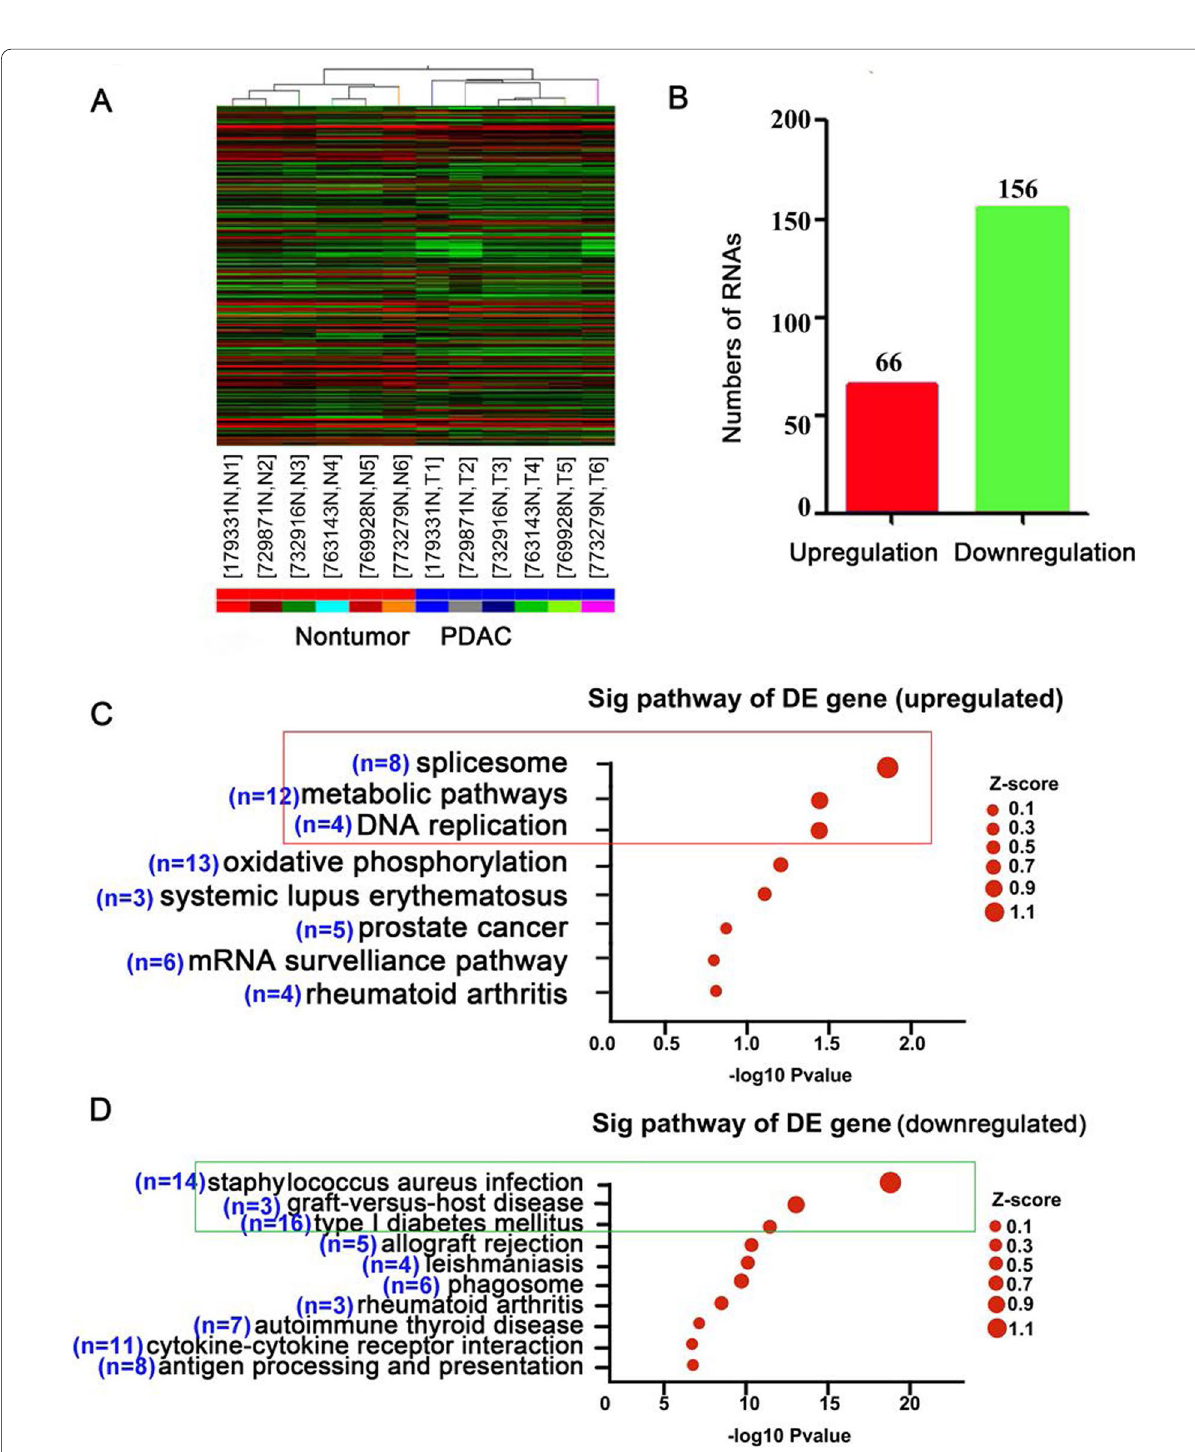
Fig. 2 Microarray analysis of differentially expressed mRNAs between six pancreatic ductal adenocarcinoma (T) samples and paired non-tumor (N) samples. A Hierarchical cluster analysis of differentially expressed ( twofold change) mRNAs between six pancreatic ductal adenocarcinoma ≥ (T) samples and paired non-tumor (N) samples. The red color indicates upregulation, while the green color indicates downregulation. B A total of 222 mRNAs, with the upregulation of 66 mRNAs and downregulation of 156 mRNAs, were selected for clustering. C Gene ontology analysis of the differentially expressed genes (DE) between six PDAC tumors and paired non-tumor samples. The upregulated mRNAs are mainly aggregated in (a) the “spliceosome,” (b) “metabolic pathway,” and (c) “glycosaminoglycan and keratan sulfate” (framed in red). The downregulated mRNAs mainly associated with (d) “ Staphylococcus aureus infection,” (e) “graft-versus-host disease,” and (f) “type I diabetes mellitus” (framed in